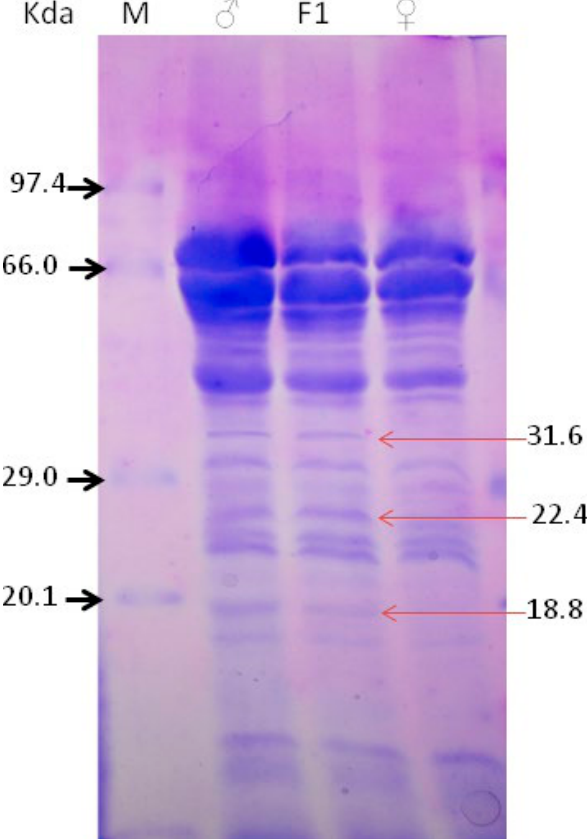
Fig. 3. Inheritance of seed albumin markers to intra-specific F 1 hybrid ( C. ternatea acc. CtB3-SL1 X C. ternatea acc. CtW2-BL1 ) intra-specific F 1 hybrid; Lane ‘M’ represents Mol. Weight Marker (PMW-M, GENEI, India), and arrow indicates on right hand side indicate the polypeptides inherited to the F 1 hybrid (MW in